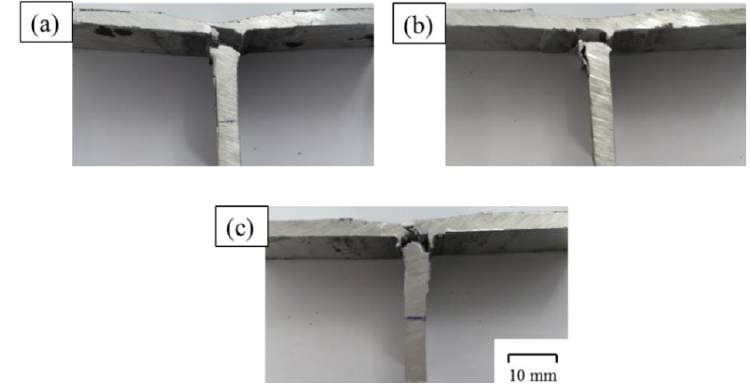
Figure 16. Photographs of fracture locations of T-butt welded specimens along skin. ( a ) 400 rpm, ( b ) 600 rpm, and ( c ) 800 rpm.